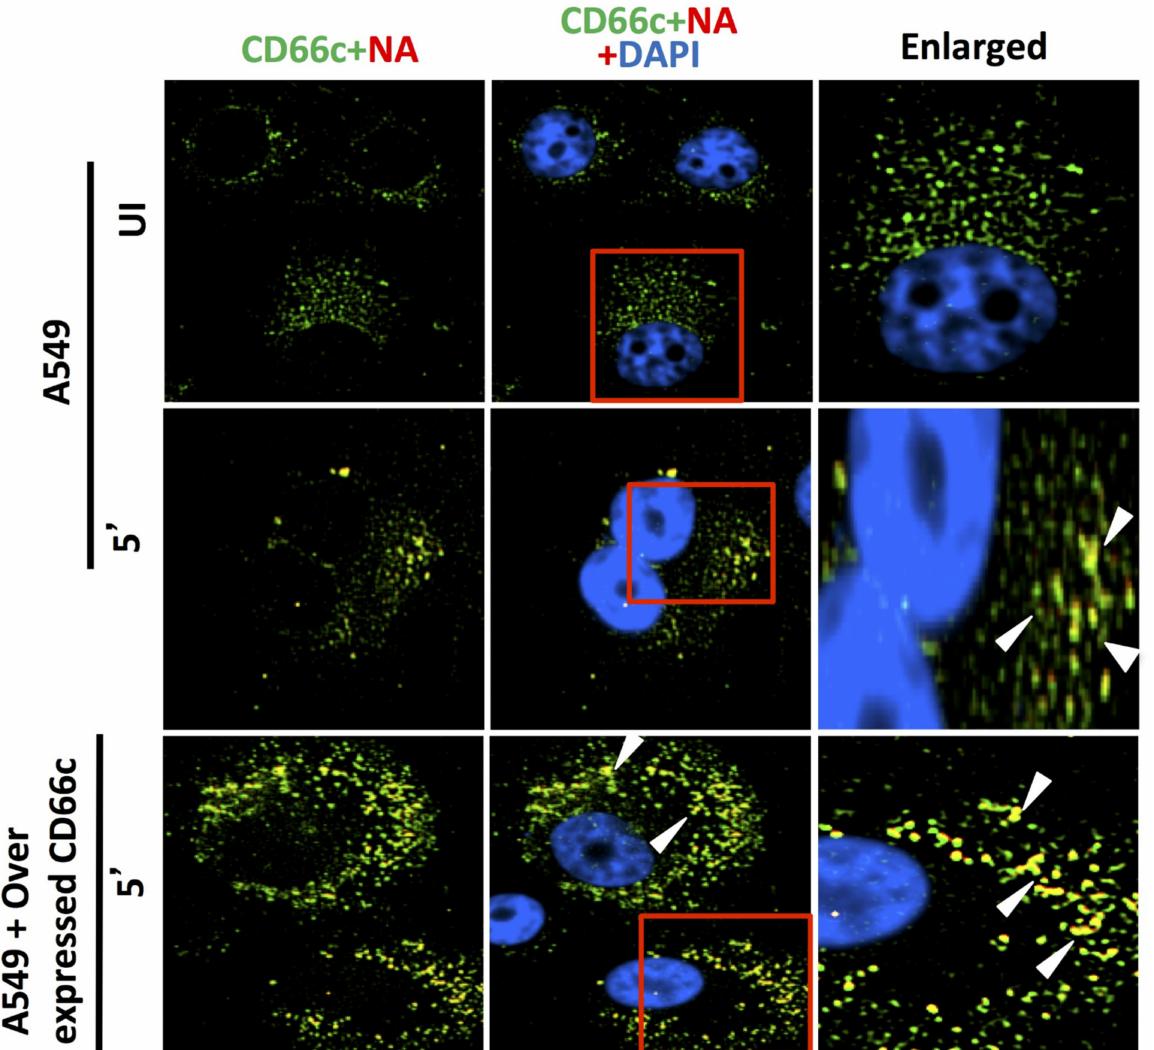
Figure 10. Cells stained for endogenous expression level of host CD66c (green) and influenza NA (red) after 5 min (5 (cid:48) ) showed significant virus binding on cell surface as probed by influenza neuraminidase NA (red) (middle panel). Cells also showed colocalization (yellow spots) between endogenous levels of receptor CD66c (green) with influenza neuraminidase NA (red). Unbound influenza NA (red) is not easily identified as most are seen merged (as yellow) with CD66c. No trace of virus binding in uninfected cells (UI, upper panel). Cells overexpressing receptor CD66c shows significant increase in virus binding and co-localization of CD66c with NA (yellow dots) on the cell surface (bottom panel) when compared to cells with endogenous level of CD66c (middle panel). CD66c (green) mainly at the periphery of cells interacting with significant number of NA (yellow after merge, white arrow). Altogether, virus binding with CD66c is prominent and significantly increased with overexpression, highlighting the strong binding ability of receptor CD66c as compared to EGFR and